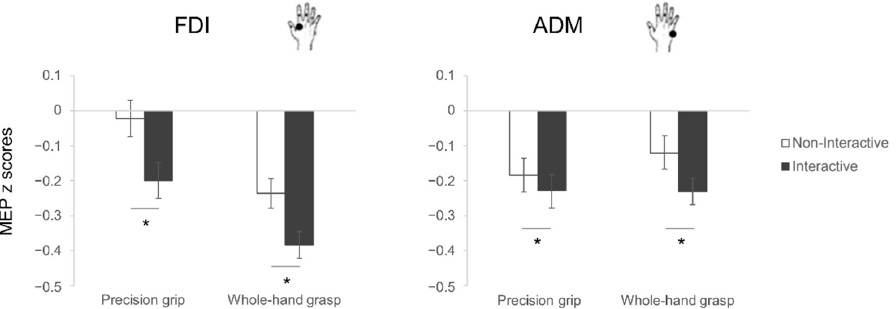
Figure 2. MEP results. Normalized MEP amplitude (z scores) of the FDI ( left ) and ADM ( right ) muscles during action preparation of precision grips (PG, stirring) and whole-hand grasps (WHG, lifting) under Non-Interactive (white) and Interactive (black) conditions. The error bars represent standard error of the mean. Asterisks indicate significant differences ( p < 0.05) between conditions (planned contrasts).